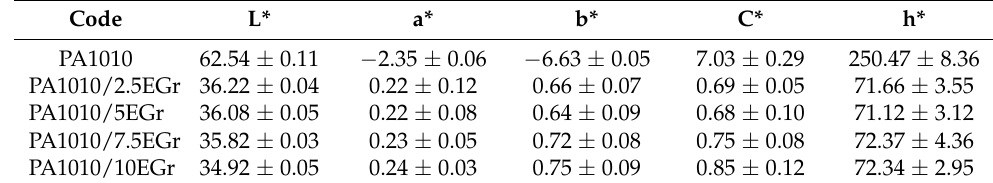
Table 6. Luminance and colour coordinates (L*, a*, b* and C*, h*) of PA1010/EGr samples. Code